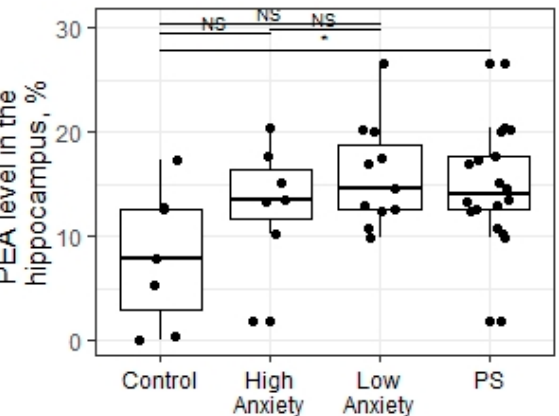
Figure 7. PEA levels (%) in the hippocampus of PS rats segregated into high- and low-anxiety groups according to AI as determined by performance in the EPM. Differences in PEA levels among groups are shown as boxplots with dots representing individual data values and medians shown by horizontal lines. The boxes include the central 50% of the data, i.e., from the 25th to the 75th percentile. The whiskers include the data contained within 1.5 times the interquartile range. NS—non-significant, p > 0.05; * p < 0.05. p values were determined in non-parametric analysis. The Kruskal–Wallis test detected a significant difference between experimental groups in the hippocampal level of propanol2-soluble ketodiens and conjugated triens (X = 11.42; p = 0.003; Figure 8). In the PS group, the concentration of ketodiens and conjugated triens was higher (W = 25.5, p = 0.025) than in non-stressed control rats. In low-anxiety rats, the hippocampal concentration of ketodiens and conjugated triens was also higher than in control rats ( p = 0.006) and higher in comparison to high-anxiety rats ( p = 0.019). In high-anxiety rats, the concentration of ketodiens and conjugated triens did not signifi- cantly differ from those of control rats ( p = 0.61).